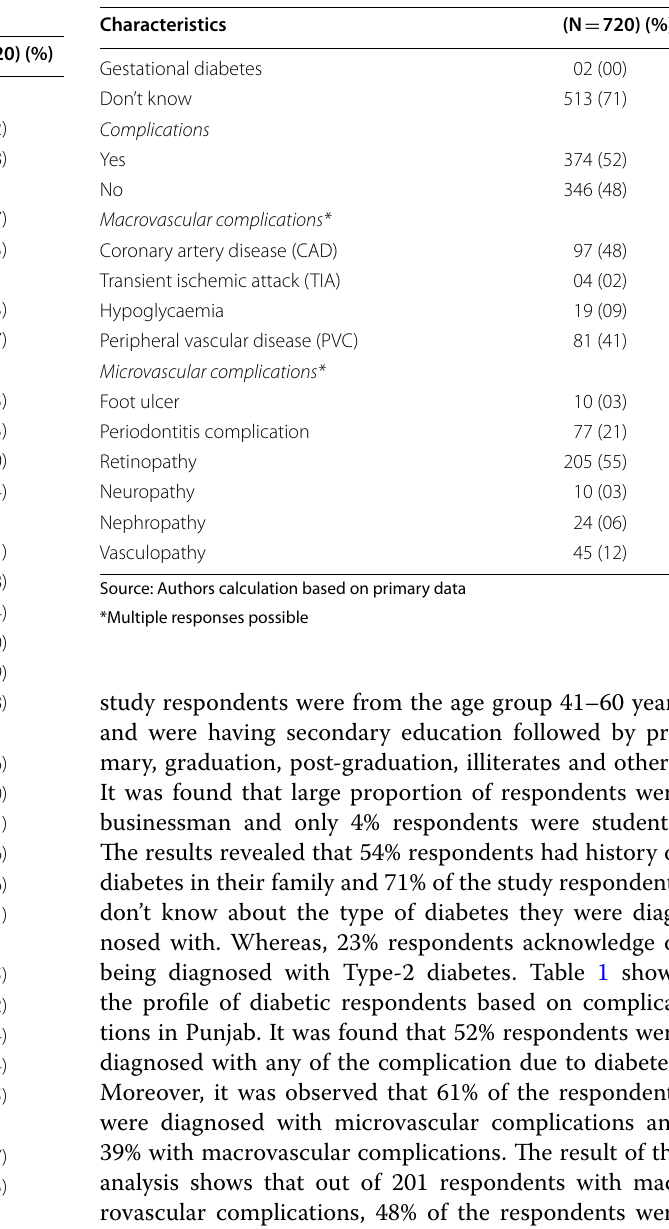
Table 1 Socio-demographic profile of the study